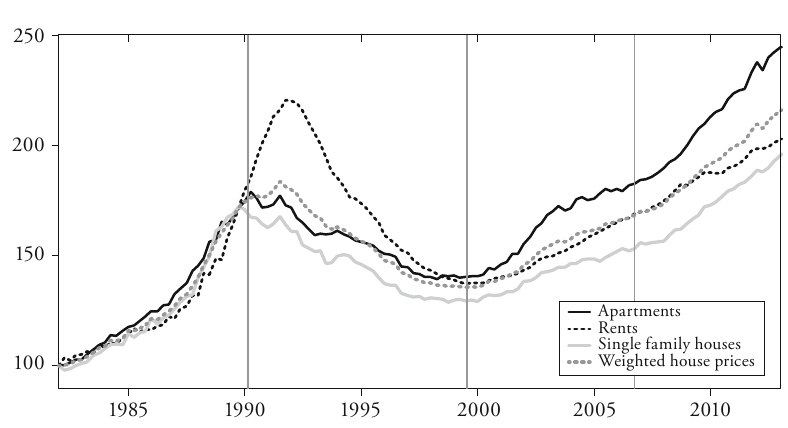
Figure 1: Swiss House